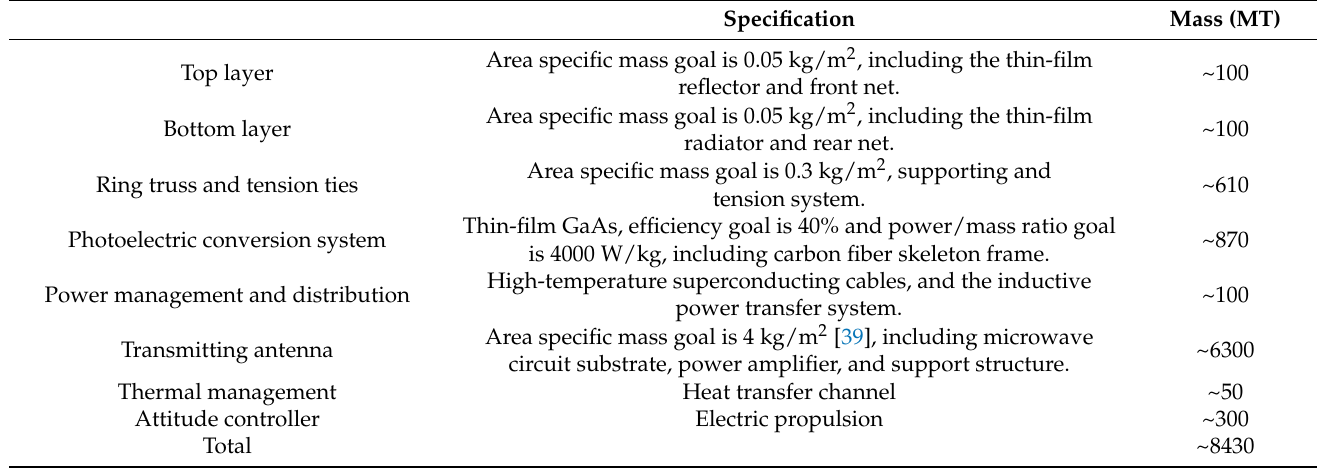
Table 7. Preliminary system weight